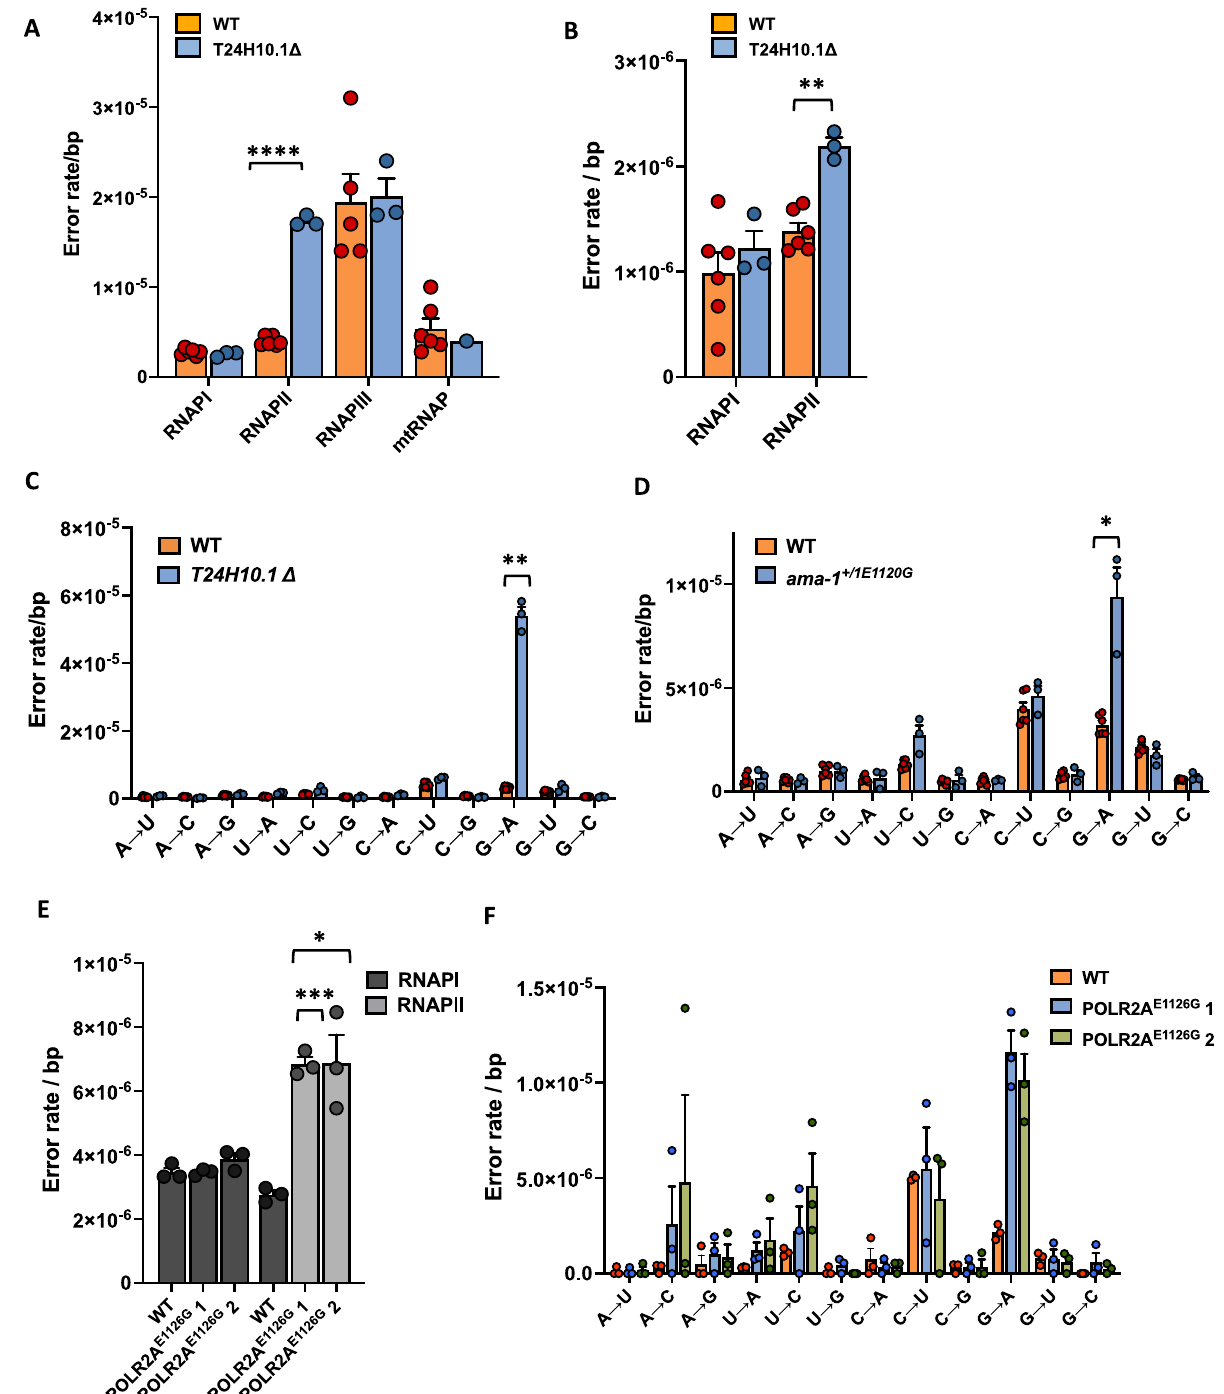
Fig. 3 | The error rate of transcription in genetically engineered worms and human cells. A Worms that carry a partial deletion in the T24H10.1 gene ( n =3, P <0.0001) display an increased error rate in RNAPII but not RNAPI, III or the mitochondrial RNA polymerase compared to WT worms ( n =6). B RNAPII in T24H10.1 Δ worms (n=3) display an increased insertion rate compared to WT worms( n =6, P =0.0004). C TheincreasederrorrateofT24H10.1 Δ worms( n =3)is primarily fueled by G → A errors ( P =0.0025). D Worms that carry a heterozygous mutationinthe ama-1 gene( ama-1 +/E1120G , n =3)displayanincreasedG → Aerrorrate